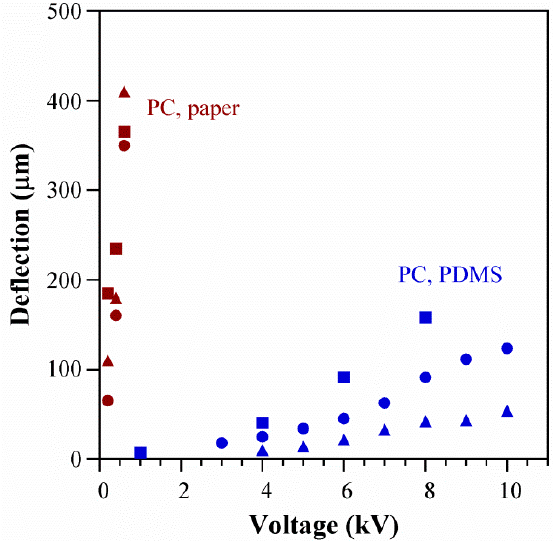
Figure 8. Deflection as a function of voltage in three paper-based stacked configurations ( red ) and in three PDMS microchannel devices ( blue ) [8], both filled with PC. The symbols for the stacked configuration have the same meaning as in Figure